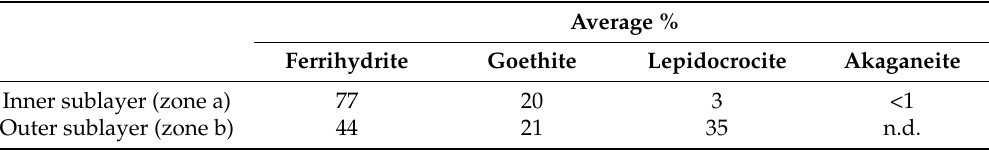
Table 1. Average phase contents in zone a (inner sublayer) and zone b (outer sublayer) of Figure 6. n.d.: not